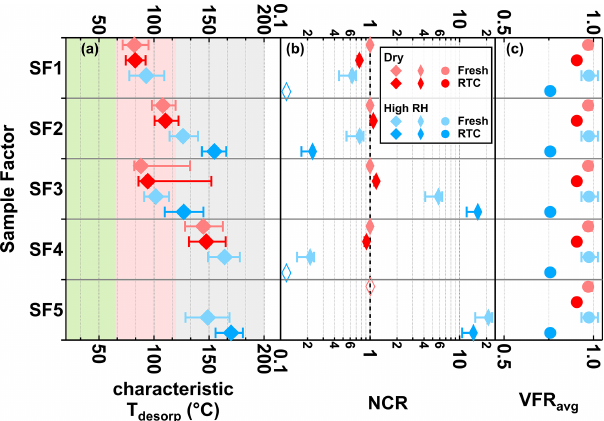
Figure 5. Characteristic desorption temperature (characteristic T desorp with 25th, 50th, and 75th percentiles, a ), net change ratio (NCR, b ) of main sample factors, and mean values of volume frac- tion remaining (VFR avg , c ) of the SQTmix SOA particles at fresh (avg. t R = 0 . 25h) and RTC (avg. t R = 4 . 25h) evaporation stages under dry (red) and high-RH (blue) conditions. Background col- ors in panel (a) indicate the volatility categories derived from the T max − C ∗ calibrations (green – SVOC; red – LVOC; and gray – ELVOC). Note that values of VFR avg are identical in each row of panel (c) . The error bars of NCR represent values accounting for changes in molecular weight and particle density, while those of VFR avg indicate the minimum and maximum values during the FI- GAERO sampling time. If the factor thermogram contributes less than 5% to total signals of sample factors and does not exhibit a clear maximum, the corresponding characteristic T desorp values will not be calculated and the NCR will be indicated by an open rhombus close to